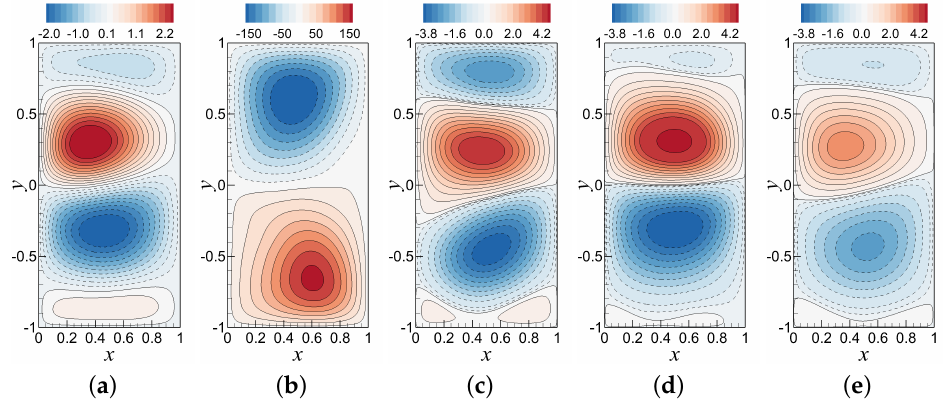
Figure 15. Sensitivity analysis with respect to the number of neurons in ELM of fully non-intrusive ROM-ANN approach using mean stream function contour plots ( R = 10 and Re = 100): ( a ) ψ FOM ; ( b ) ψ ROM-GP ; ( c ) ψ ROM-ANN with Q = 20 neurons; ( d ) ψ ROM-ANN with Q = 40 neurons; and ( e ) ψ ROM-ANN with Q = 80 neurons.